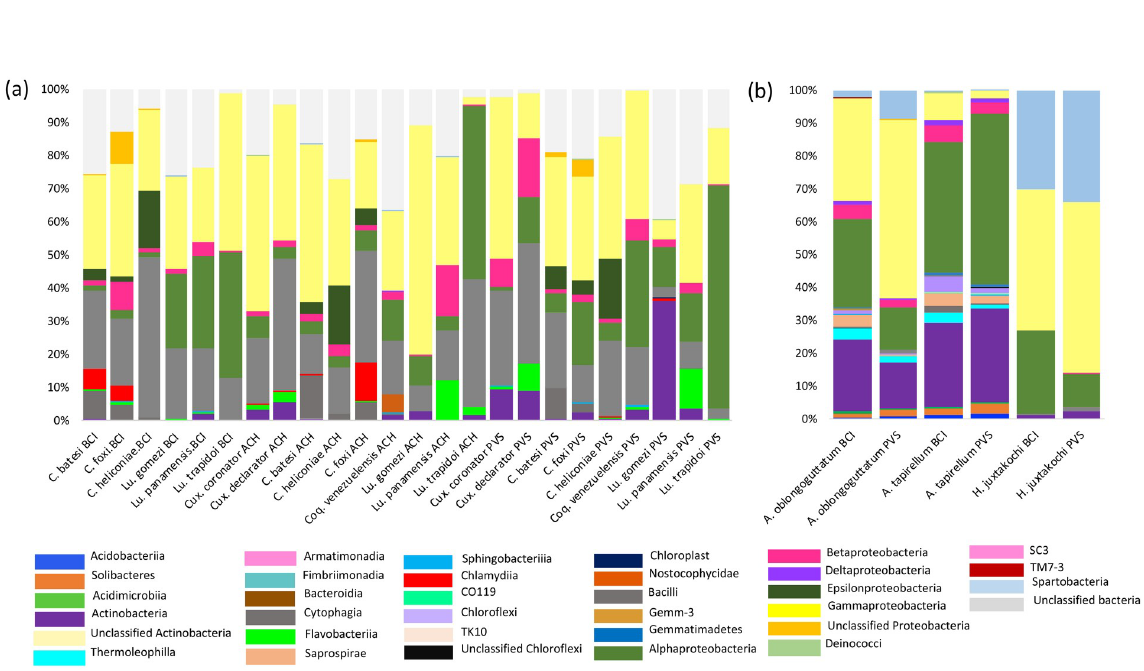
Fig 4. Relative abundances of bacterial classes summarized for (A) dipteran species and (B) hard ticks gathered from BCI (i.e., Pristine), ACH (i.e., intermediately disturbed) and PVAS (i.e., highly disturbed).